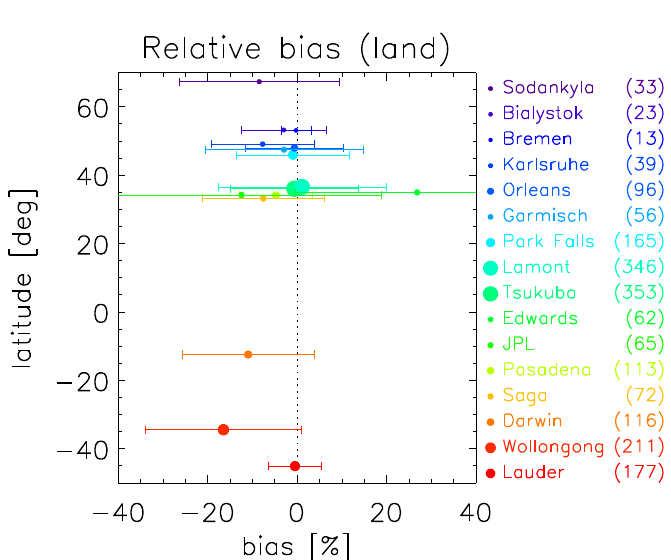
Figure 3. Mean relative bias (filled circles) and associated standard deviation (“error bars” representing ± σ ) as a function of the latitude of the TCCON sites, for coincidence criteria of ± 30min and ± 1 ◦ in latitude and longitude. The dataset names and corresponding number of coincidences are shown on the right-hand side, color-coded from purple to red in order of decreasing latitude from the northernmost site (Sodankylä, 67.4 ◦ N) to the southernmost station (Lauder, 45.0 ◦ S). The size of the symbols is proportional to the number of coincidences at each